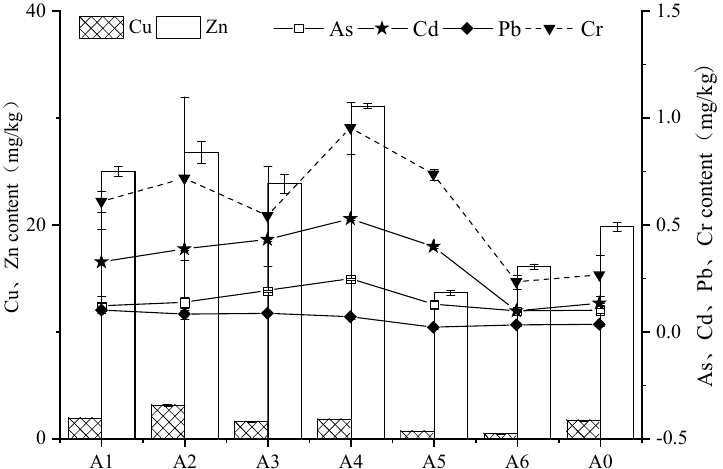
Figure 6. Changes in heavy metal content in soft tissue of middle barnacle at different monitoring stations (wet weight).